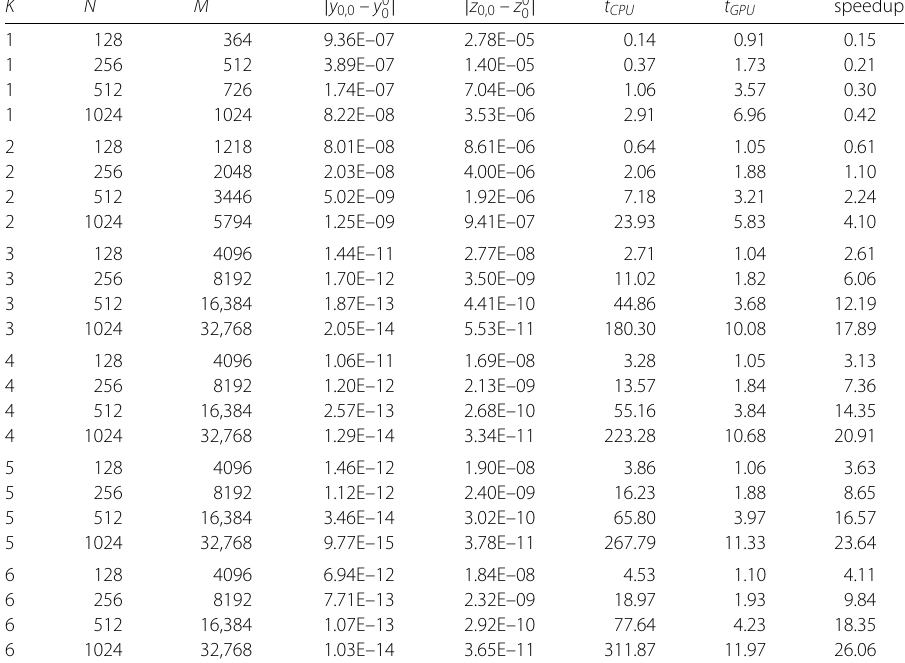
Table 4 The results for Example